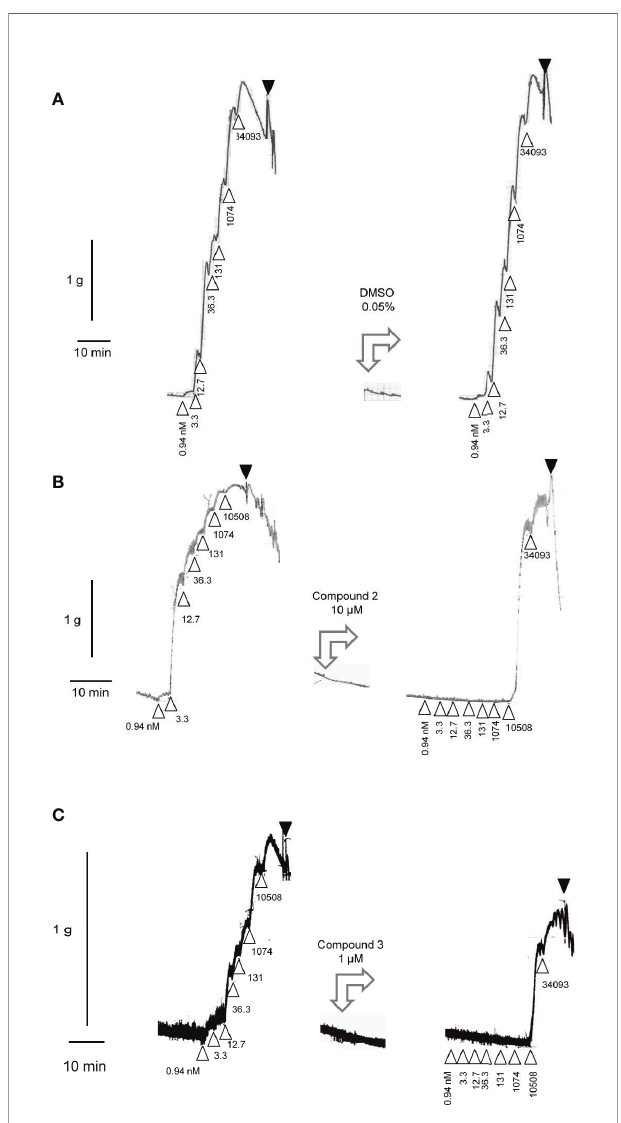
FIGURE 2 | All panels, left tracings: Construction of a cumulative concentration-effect curve for BK-induced contraction by using a ring of human umbilical vein pre-equilibrated for 3 h. Abscissa scale: time; ordinate scale: isometric contraction, grams. D indicates the application of BK (cumulative nanomolar concentration indicated) and ▼ the fi rst of a series of washouts. All panels, middle tracings: the tested small molecule antagonists or their DMSO vehicle exerted no contractile effects. All panels, right tracings are recorded in the same tissues at time 5 h. The DMSO vehicle has no major effect on the previously recorded response to BK (sensitivity, maximal effect) (A) . Compound 2 (B) or Compound 3 (C) at a high concentration depressed both the sensitivity of the same ring to BK and, slightly, the maximal effect of the peptide (estimated from the previously recorded E max